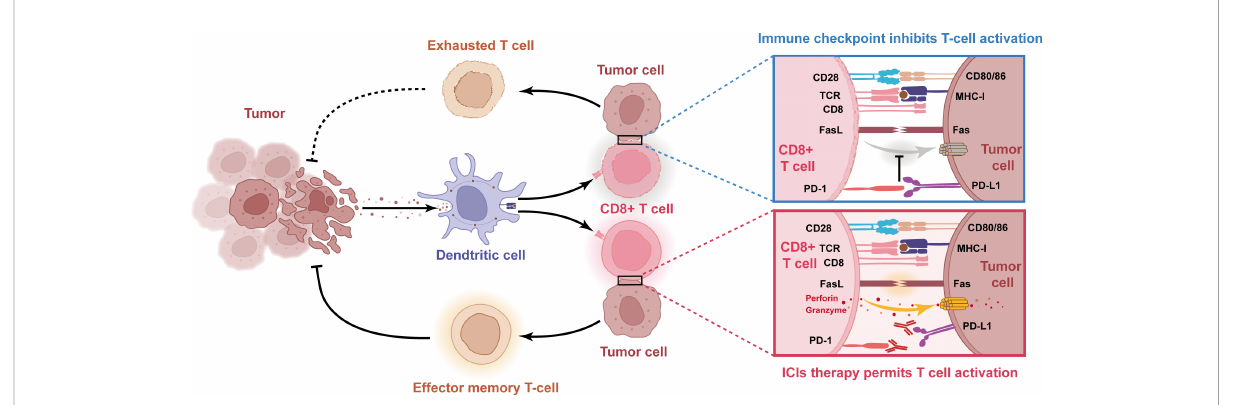
FIGURE 3 Schematic diagram of the molecular mechanism ofimpaired anti-tumor immunity caused by immune checkpoints and reactivation ofT cells with PD- 1/PD-L1 blockingantibody.Whentumor cell PD-L1 binds to T cellPD-1, this interactionleads to T cell dysfunctionand lack of anti-tumor activity. Thus, blocking the interactionbetween PD-1 andPD-L1 with anti-PD-1 or PD-L1 antibodies can reactivate T cells and release their anti-tumoractivity.